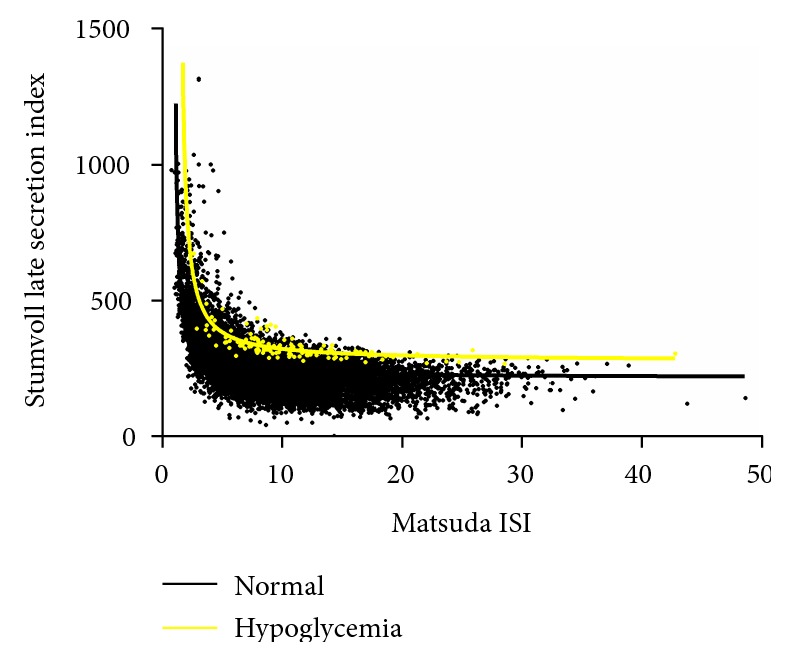
The insulin secretion of late stage and insulin sensitivity levels between participants with biochemical postprandial hypoglycemia and NGT.